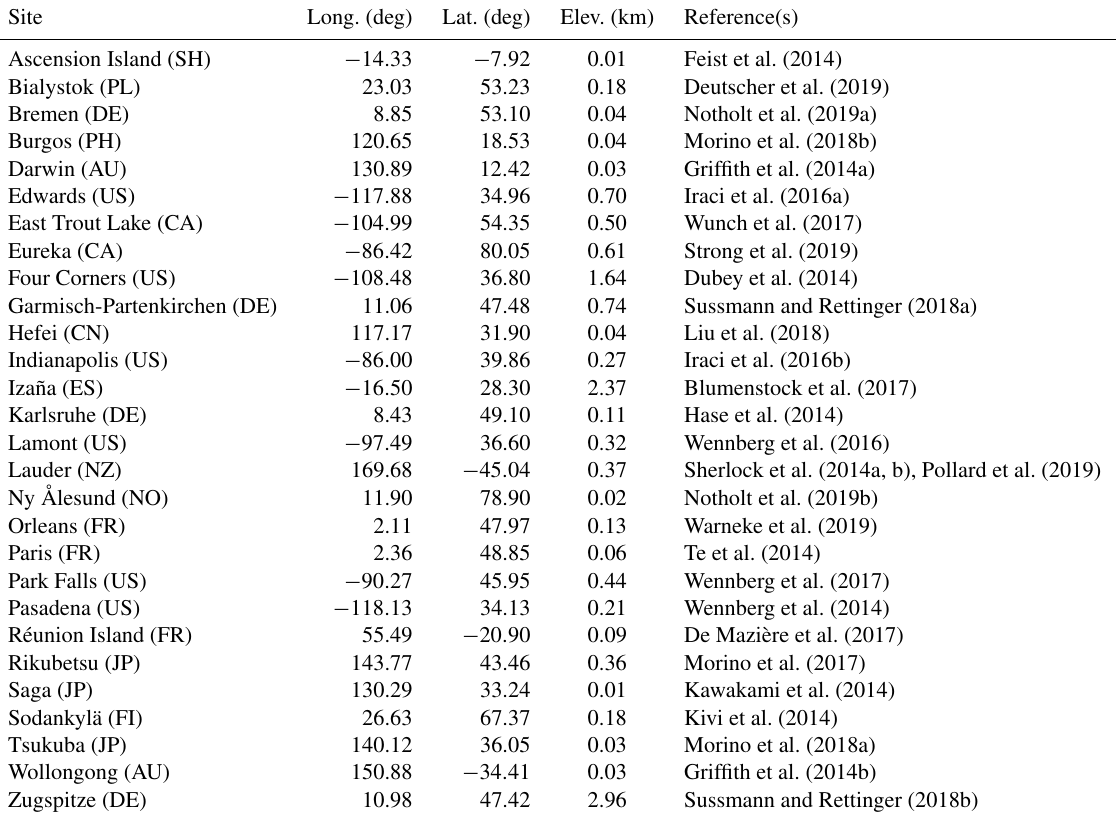
Table 1. TCCON stations used in this